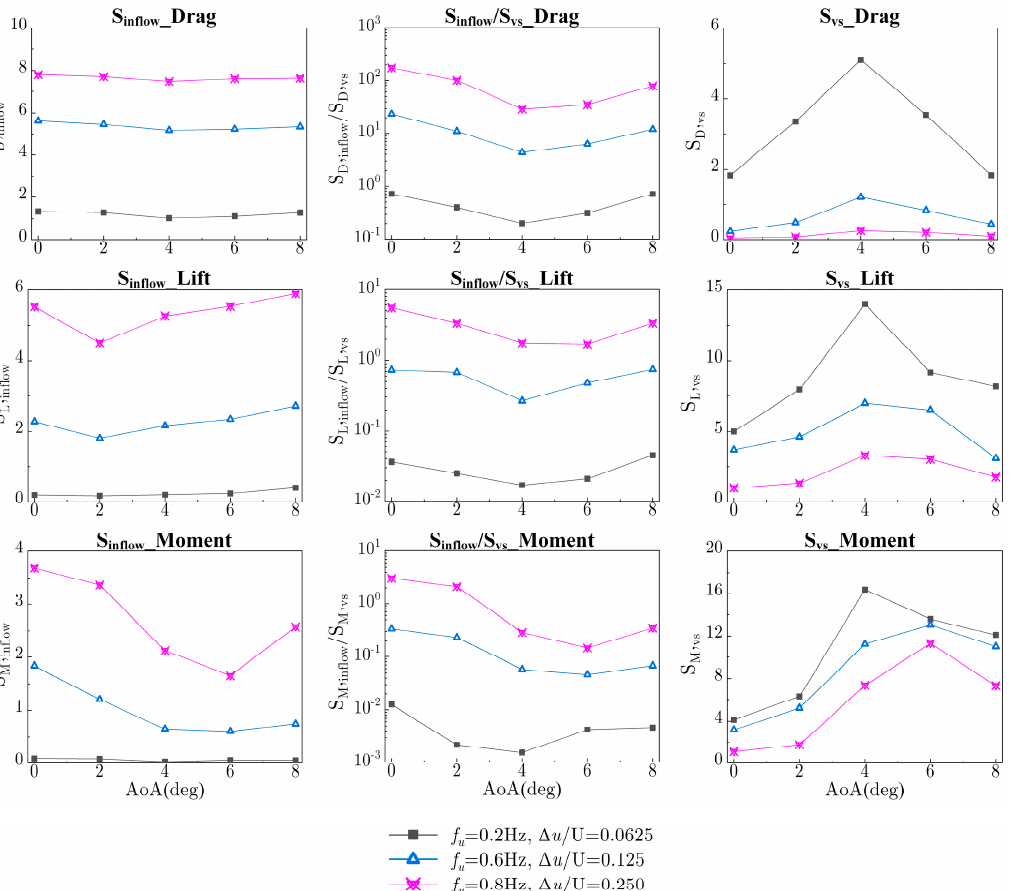
Figure 11. Effects of AoA on the inflow oscillation contributions (left column), on the vortex shedding contributions (right column), on the ratios between the two contributions (middle column) for drag, lift, and pitching moment.